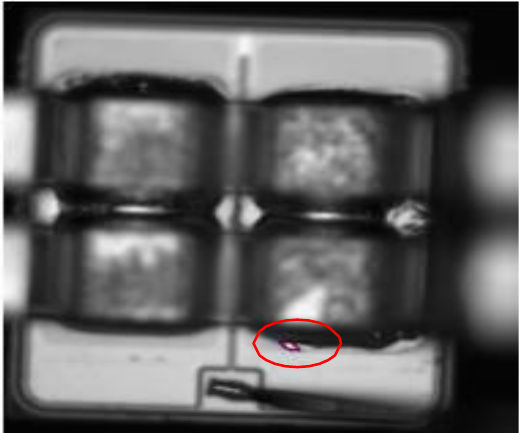
Fig. 10 . Image obtained by the merge function The